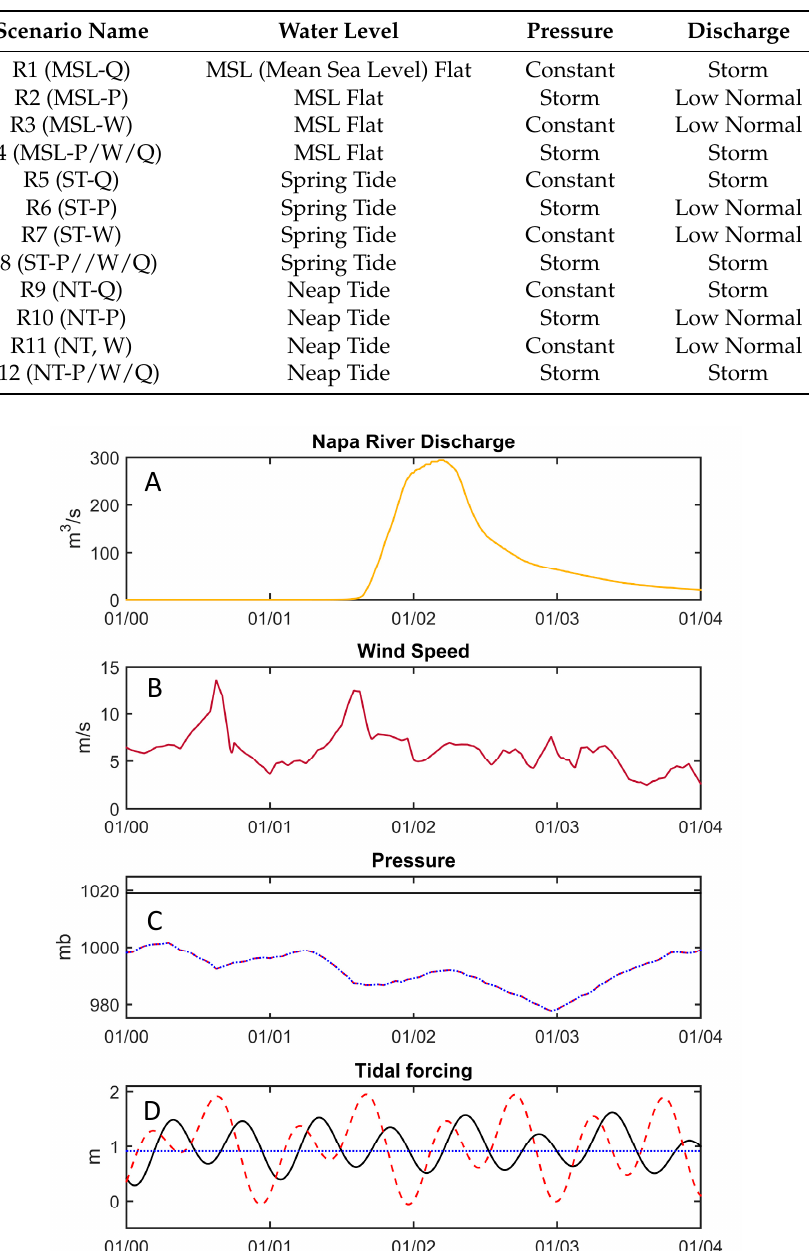
Table 2. Realistic model scenario titles and forcing included.